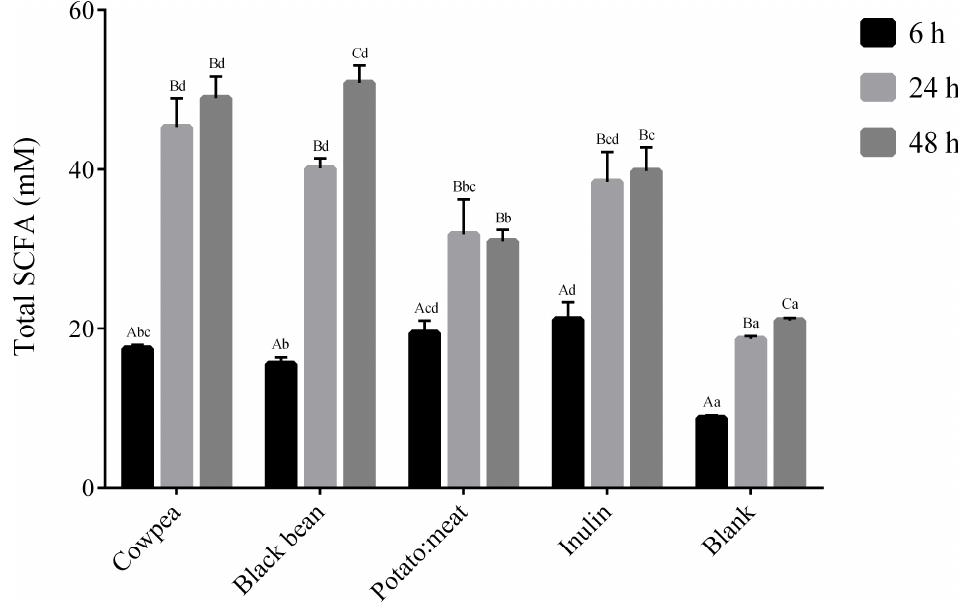
Figure 1. Total short-chains fatty acids (acetate, propionate and butyrate) produced during fermentation time (6, 24 and 48 h). Results are expressed in mM. The data marked by the same letters were not significantly different ( p > 0.05). Different uppercase letters for comparison within each fermentable source at a different time and lowercase letters for comparison within the different fermentable source at the same time, indicating significant differences at p < 0.05.